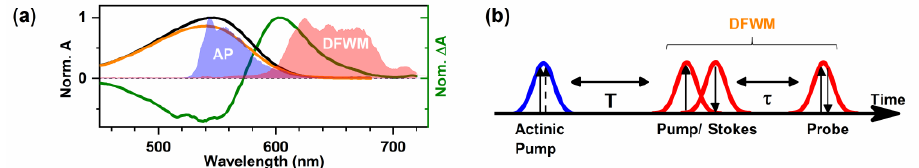
Fig. 1. (a) The spectrum of actinic pump (AP) and DFWM beams are represented by green and blue filled curves respectively. Former is resonant to ground state absorption of AT (black line) and 13C (red line) isomers of ASR and later is resonant to photo-induced absorption (green line). (b) Schematic representation of pulse sequence of Pump-DFWM